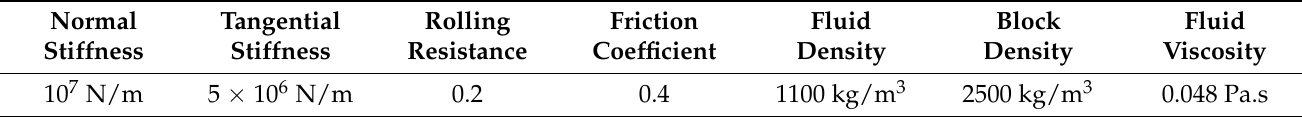
Table 3. Mechanical parameters of the model.